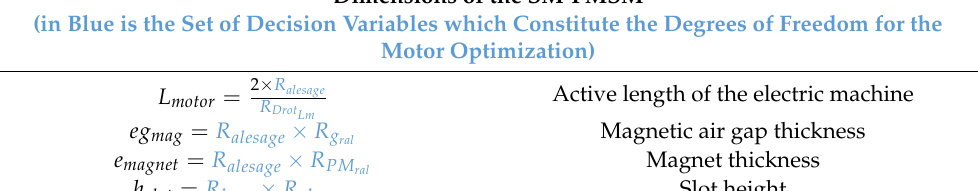
Table 3. Computation process of electric machine dimensions. Dimensions of the SM-PMSM